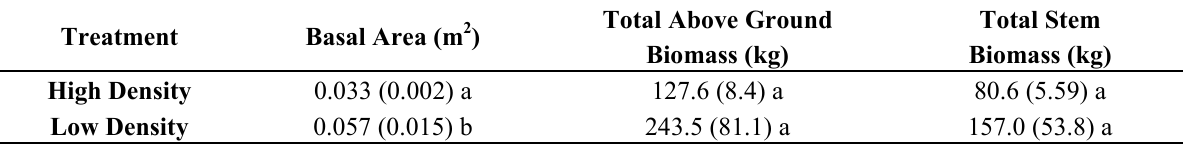
Table 2. Average (standard deviation) basal area, above ground biomass and stem biomass of red pine in the Huron National Forest, Michigan, between two density types. Different letters denote significant differences between density types ( p < 0.05).